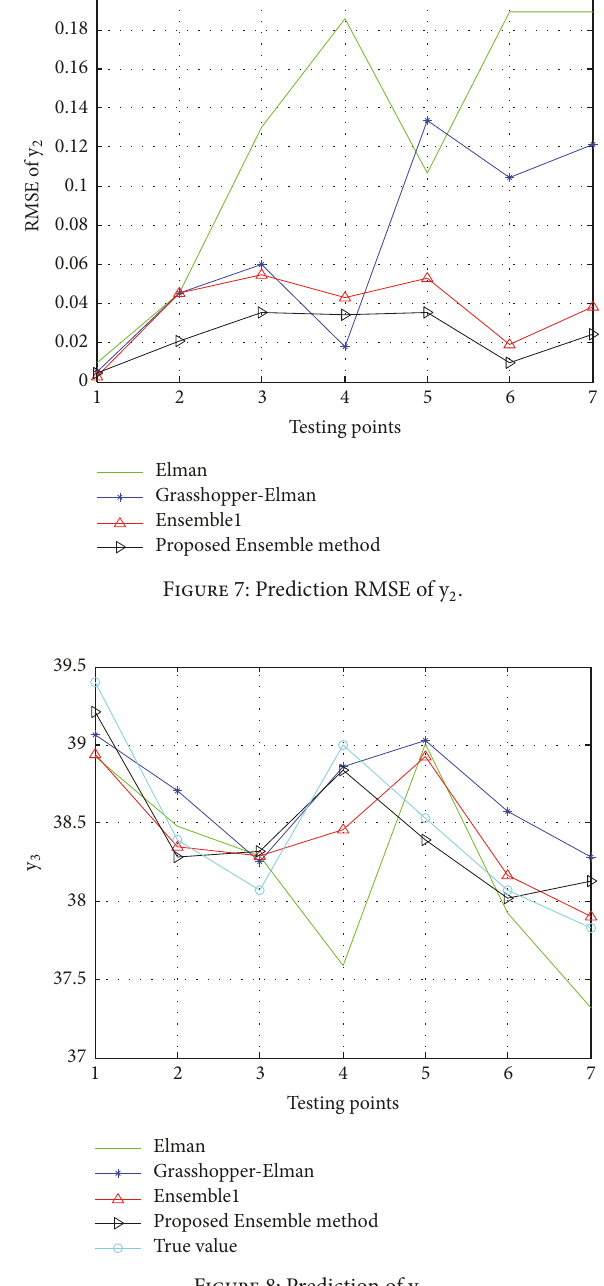
Figure 8: Prediction of y 3